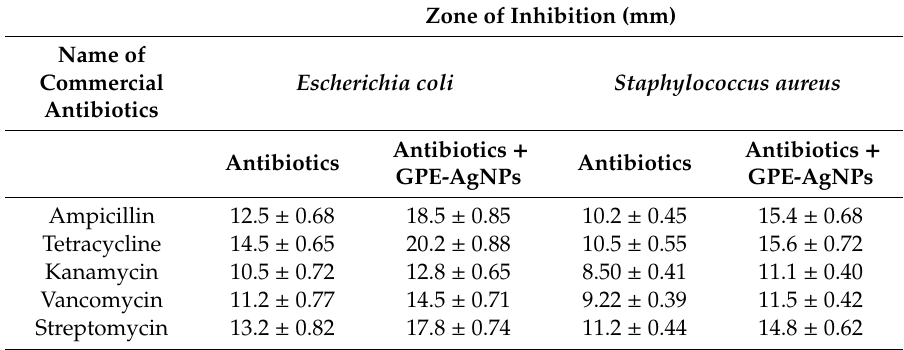
Table 3. Enhanced antibacterial activity of synthesized GPE-AgNPs in combination with standard antibiotics against Escherichia coli and Staphylococcus aureus